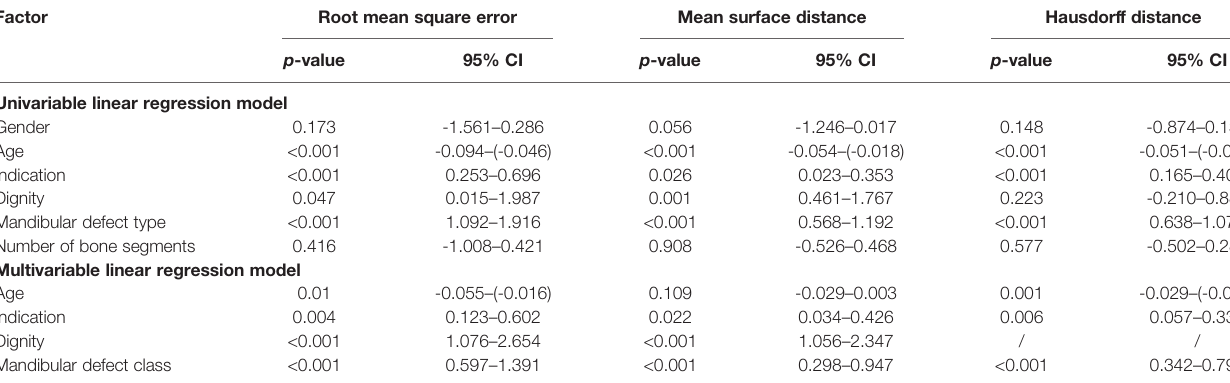
TABLE 3 | Uni- and multivariable linear regression model of the virtual-postoperative RMSE, MSD, and HD results and possible confounding factors.